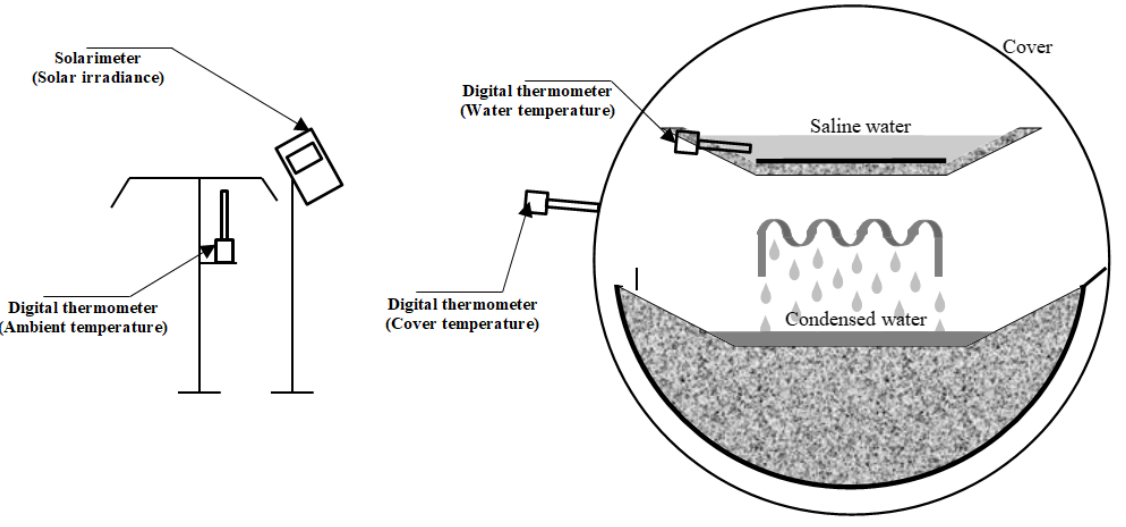
Figure 3. Measurement test bench.